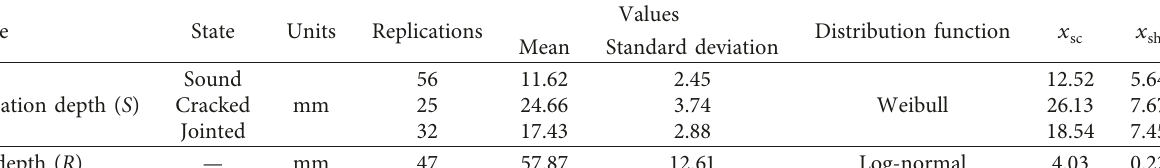
Table 1: Stochastic parameters for safety factor method.